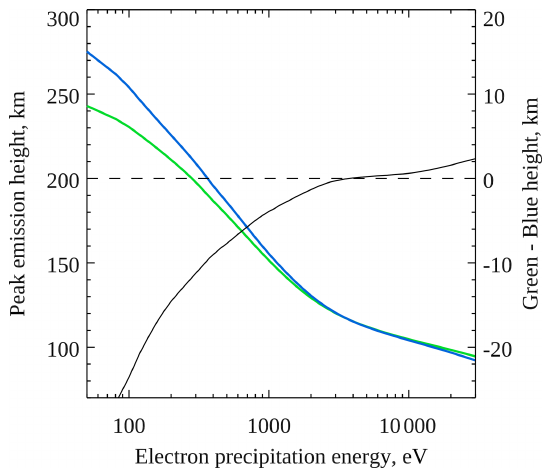
Figure 7. Peak emission heights of 557.7nm aurora (green) and 427.8nm aurora (blue) as a function of characteristic electron pre- cipitation energy for Gaussian electron spectra, obtained using the Southampton ionospheric model. The difference in these heights is shown in black, using the right ordinate axis.